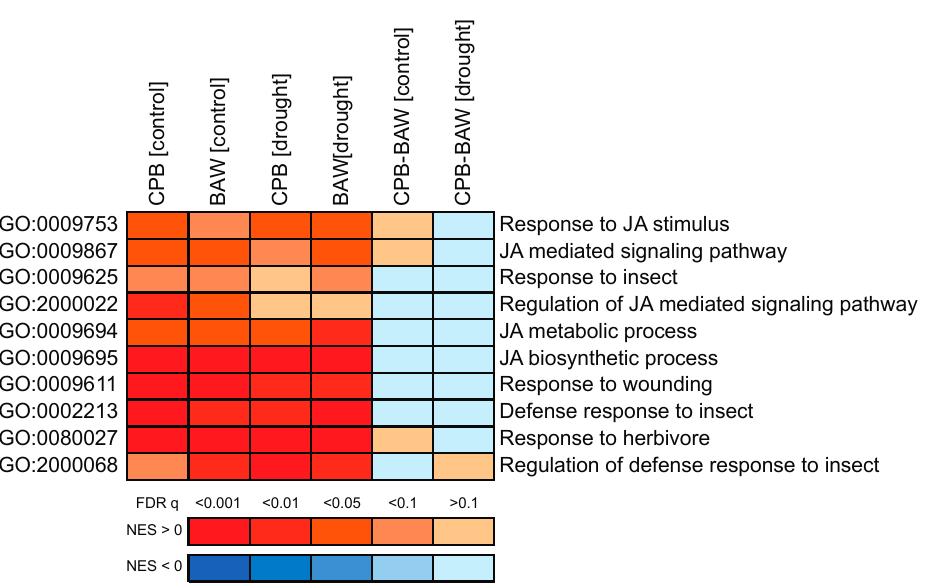
Figure 6. Induction of jasmonic acid (JA)/herbivore-related biological processes (BPs) by insect herbivory in Solanum dulcamara plants. Each column is a pairwise comparison between two conditions to show effects of herbivory by Spodoptera exigua or Leptinotarsa decemlineata under well-watering conditions (BAW (control) and CPB (control), respectively) or drought treatment (BAW (drought) and CPB (drought), respectively), or to show differences between herbivory treatments by the two insects on well-watered (CPB-BAW (control)) or drought-stressed plants (CPB-BAW (drought)). Colours indicate directions of BP enrichment based on normalized enrichment scores (NES) generated by gene set enrichment analyses: red for upregulation (positive NES) and blue for downregulation (negative NES), higher absolute values of NES indicate more significant differences. Colour scales indicate levels of significance based on the associated FDR q values. Cut-off for significance is set at q = 0.1. GO: gene